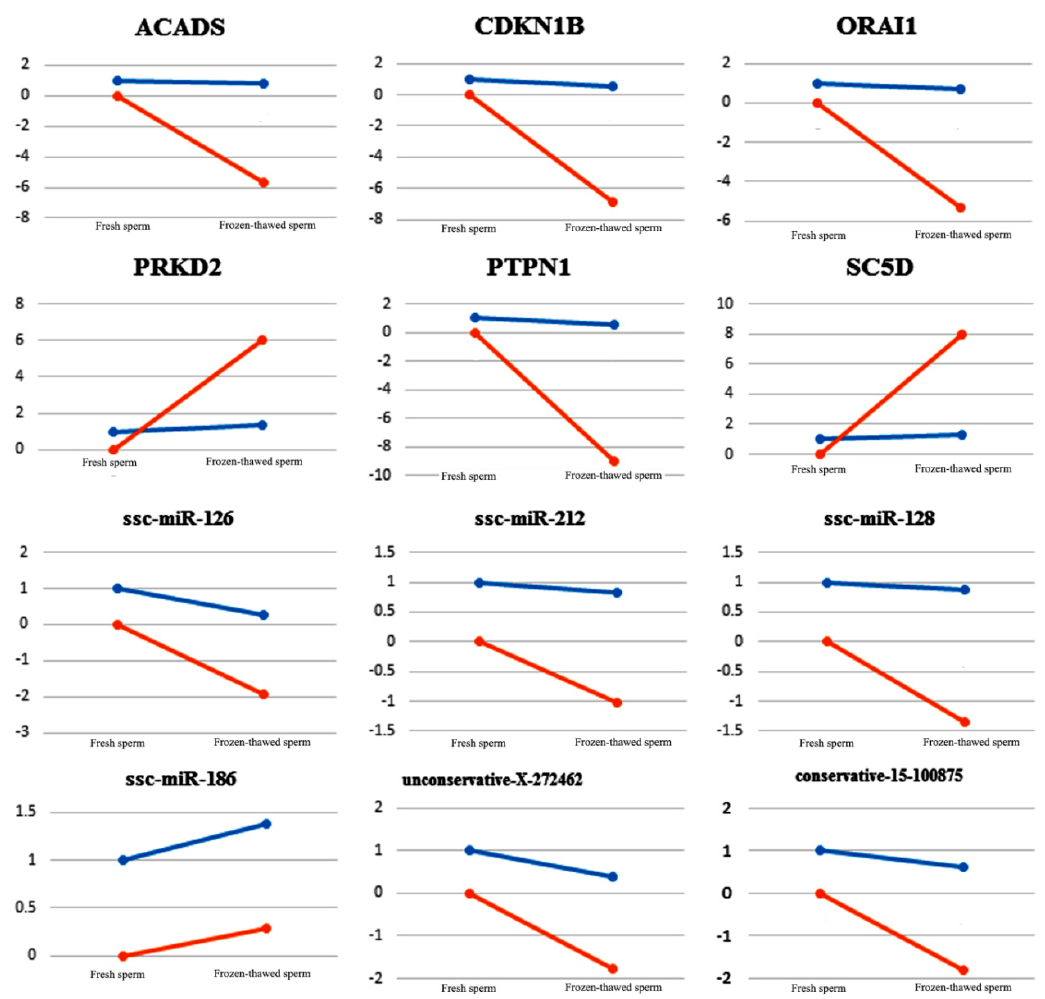
Figure 5. qRT-PCR validation of 12 differentially expressed miRNAs and mRNAs in fresh and frozen-thawed boar sperm. Blue line segments represent the result from small RNA and transcriptome sequencing. Red line segments represent the result from qRT-PCR. Detailed data are shown in Table S8.